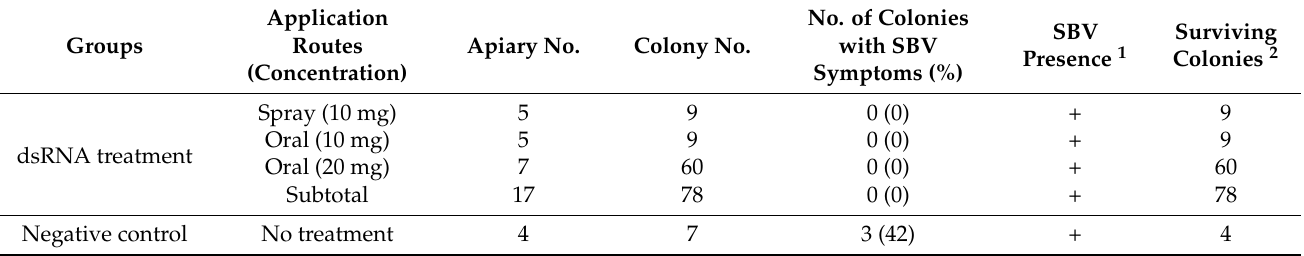
Table 1. Field application of double-stranded RNA (dsRNA) for the prevention of sacbrood virus (SBV).